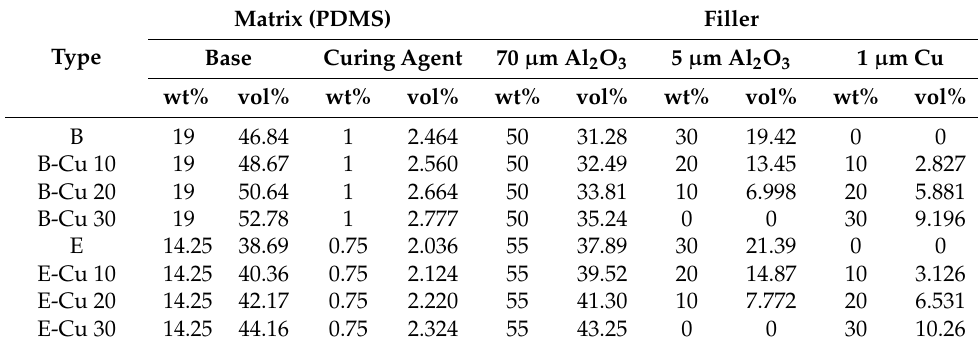
Table 4. Mixing ratio using aluminum oxide and copper